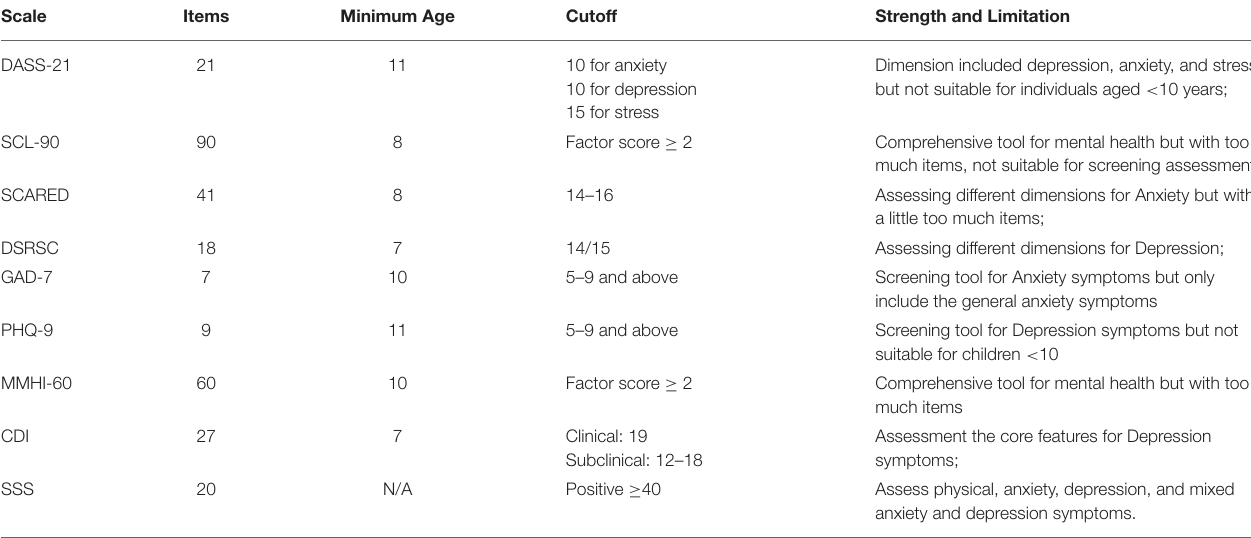
TABLE 3 | Screening tools for anxiety and